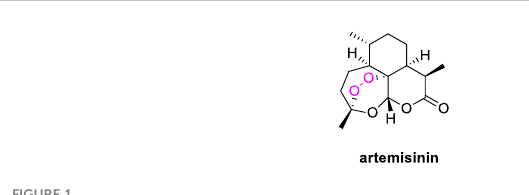
FIGURE 1 Chemical structures of artemisinin, dihydroartemisinin and